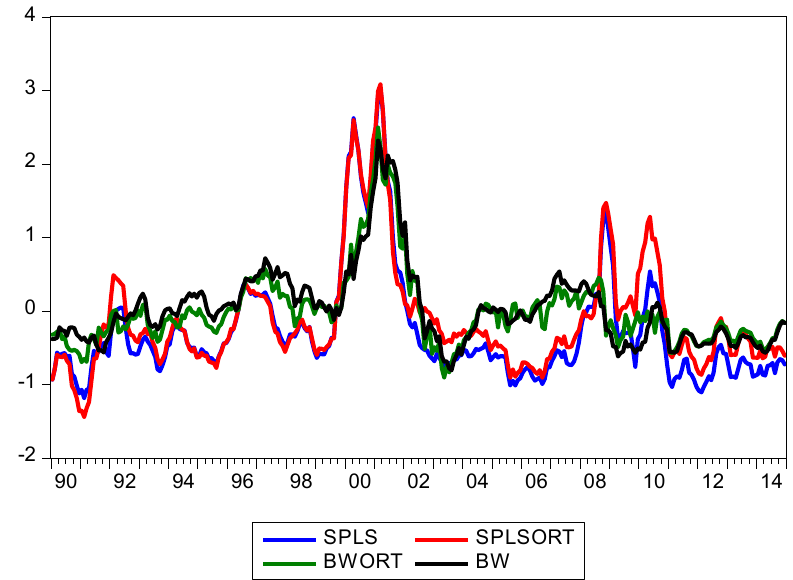
Figure 1. Plot of the sentiment indices group for the entire range of 1990–2014.